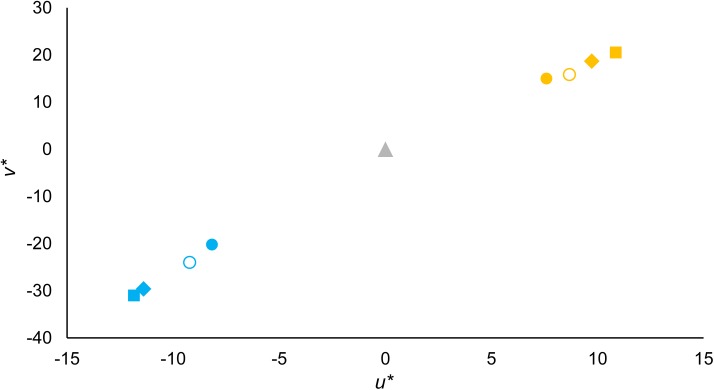
Mean thresholds for illuminants along daylight locus, plotted in CIE u*v* coordinates.Reference white corresponds to D67 illuminant (u* = 0, v* = 0, grey triangle). Data for normal observers in Pearce et al. ([14], open circles) in comparison with normal observers (solid circles), protanopes (squares) and deuteranopes (diamonds) in this study. Yellowish illuminants are represented as yellow symbols; bluish illuminants are represented as blue symbols.